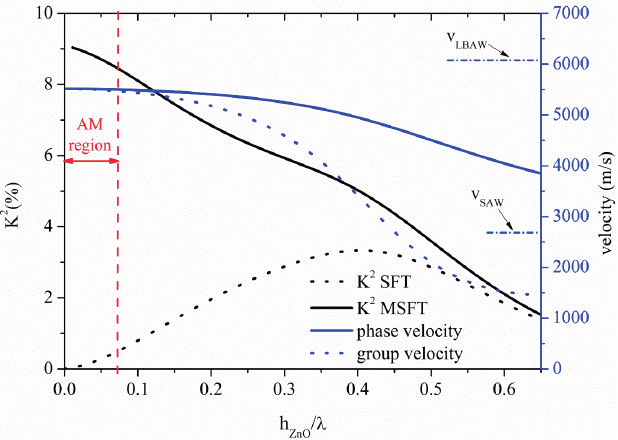
Figure 6. Phase and group velocity, and K 2 dispersion curves of the S 0 mode propagating along the MST and ST configurations on ZnO